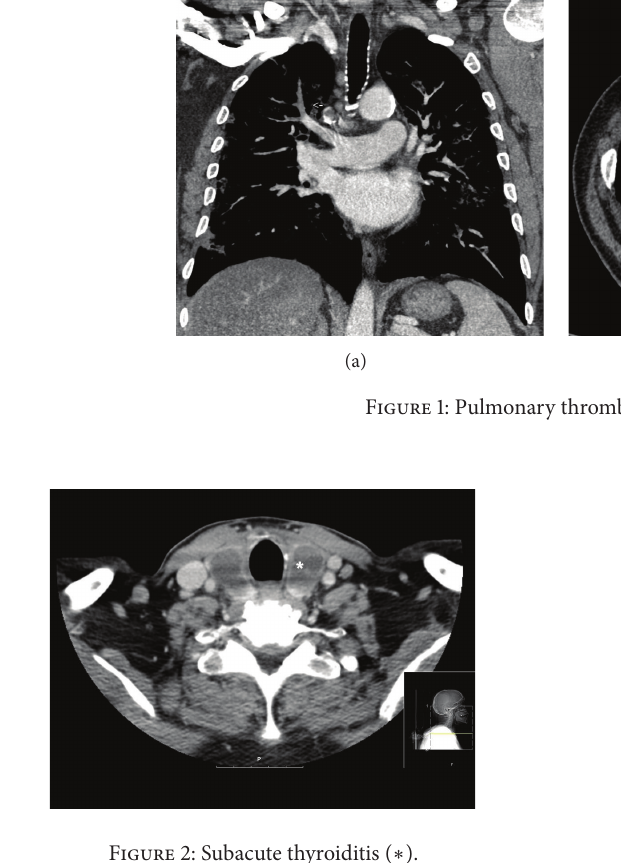
Figure 2: Subacute thyroiditis ( ∗ ). Figure 3: Pulmonary parenchymal damage.